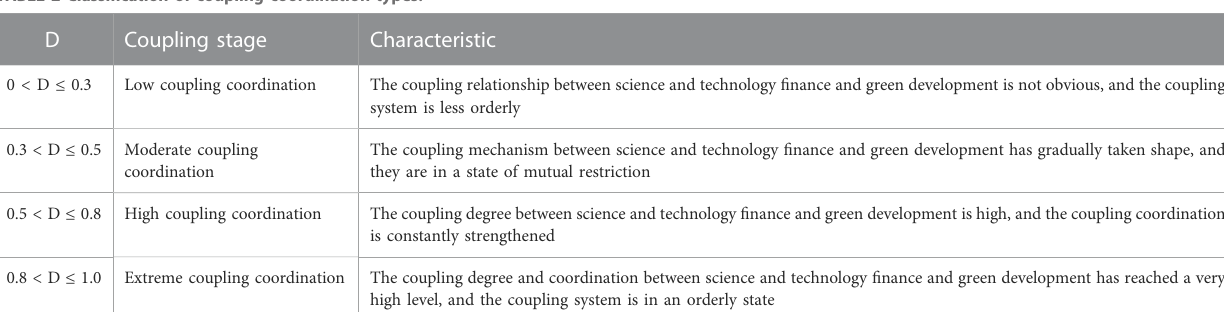
TABLE 2 Classi fi cation of coupling coordination